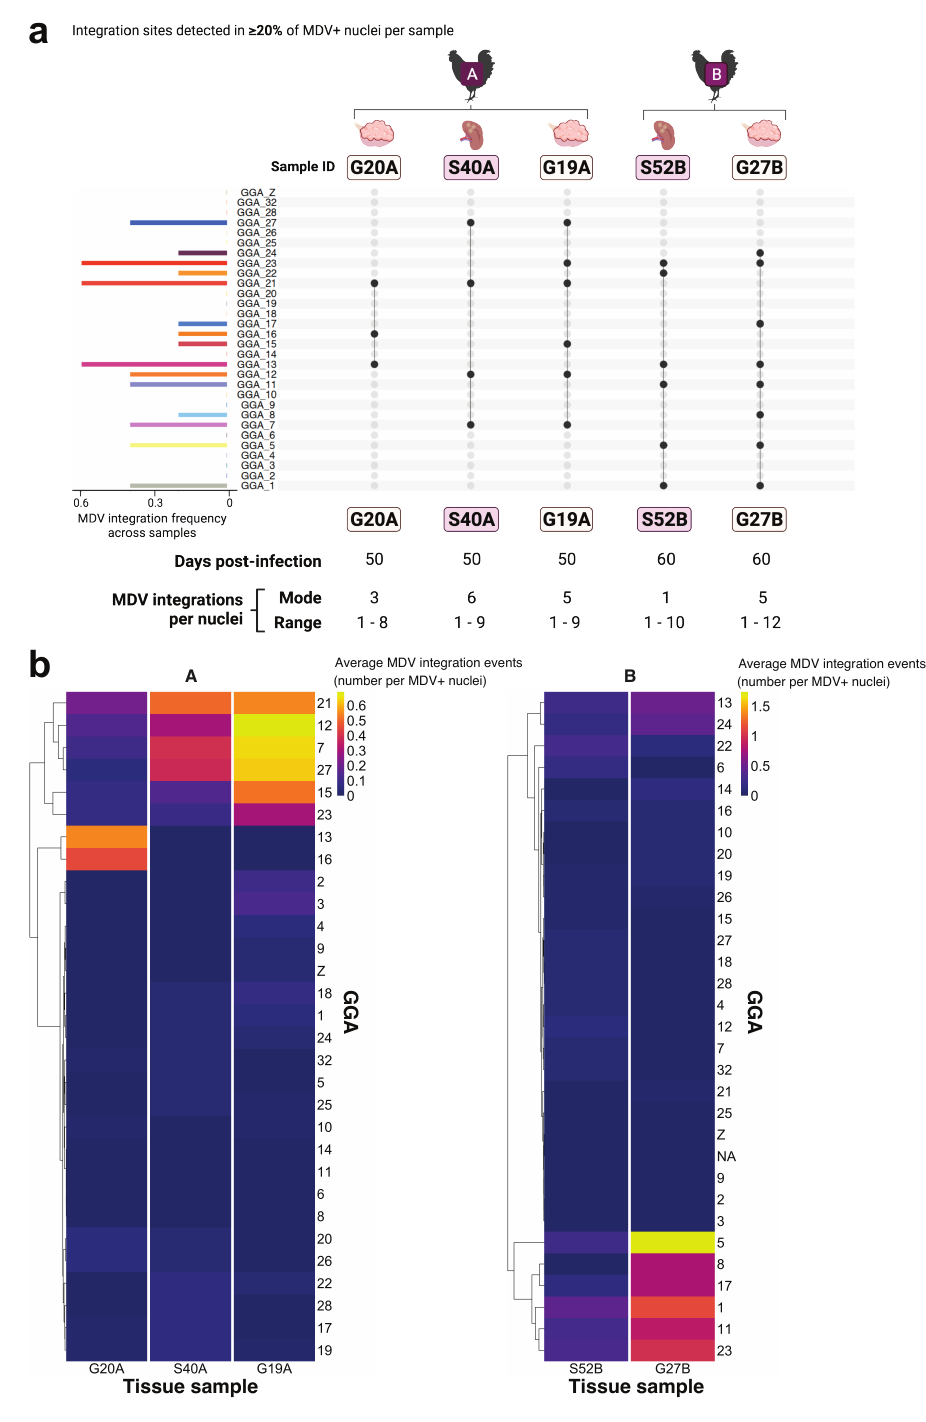
Figure 4. MDV FISH analysis reveals similar intra-individual MDV integration profiles for MD-transformed tissue samples: ( a ) Left bar graph panel depicts frequency of MDV integration for each host chromosome site among MDV integration profiles of transformed tissue samples from two different birds (denoted bird ‘A’ or ‘B’; gonad lymphoma or splenic sample identifier indicated below bird label) in study part III. The dot plot (right panel) depicts the profiles of MDV integration host chromosome sites detected in >20% of MDV + nuclei from gonad lymphomas or splenic samples from the same MD-infected bird (study part III; see Figure 1a). Tissue collection timepoint after MDV infection (dpi), and mode and range of MDV integrations per nuclei reported for each sample below the dot plot panel; ( b ) Average MDV integrations events (as counts) per MDV + nuclei for each host chromosome in MD gonad lymphomas and splenic samples of birds A and B in study part III. Y axis (with host chromosome sites) is organized by unsupervised hierarchical